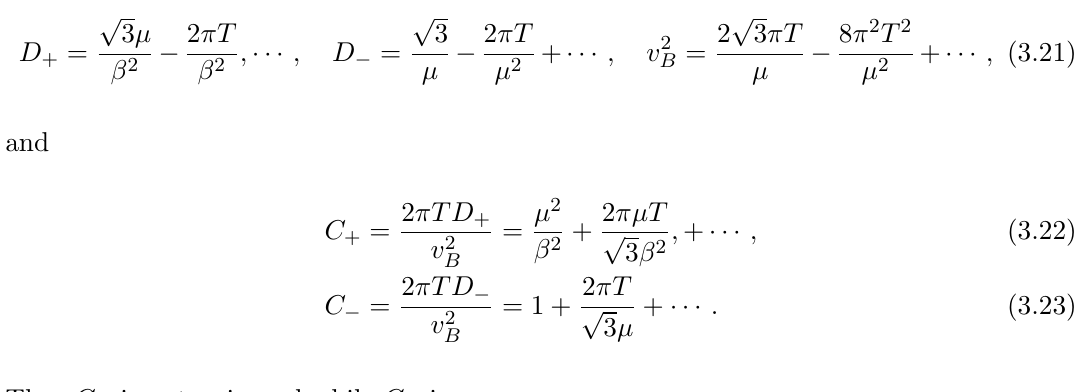
and 2 (cid:25)TD e =v 2 B B